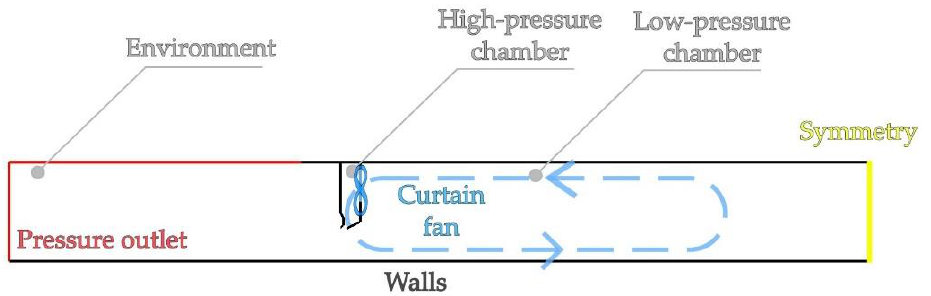
Figure 6. Scheme of the planar 2D model of the curtain-only variant of FDDG.